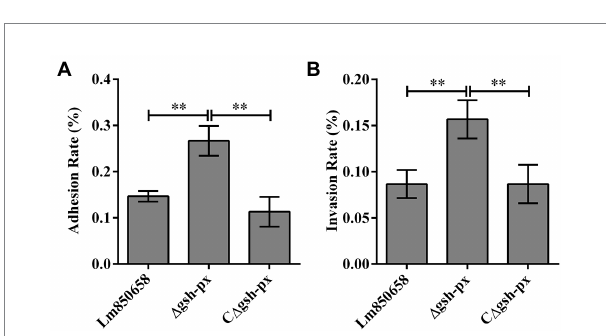
FIGURE 4 Mutation of gsh-px increased the adhesion (A) and invasion (B) ability of L. monocytogenes to Caco-2 cells. Epithelial cells Caco-2 were incubated with Lm850658, Δ gsh-px and C Δ gsh-px for 1 h, the adhesive bacteria were collected and counted by plate counting and the invasive bacteria collected after killing the extracellular bacteria with gentamycin. Finally, the adhesion and adhesion rates were calculated using the adherent and invasive bacteria divided by the initial bacteria. The experiments were conducted for triplicate and data were expressed as mean ± SD. ns, no significance; *, p < 0.05; **, p <